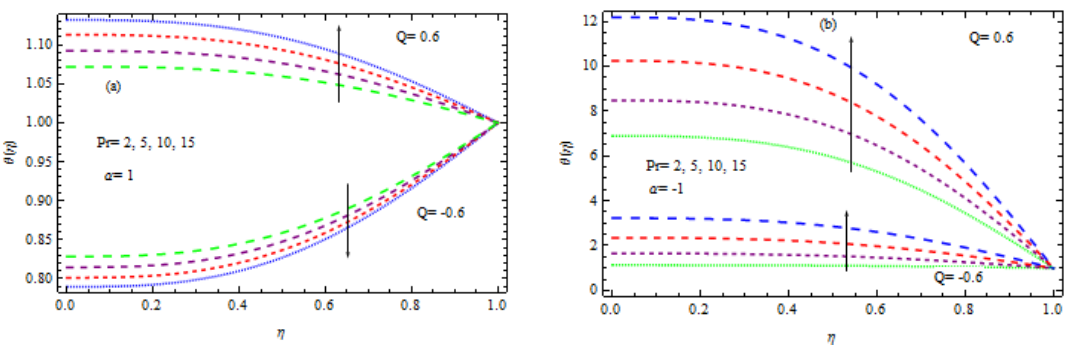
Figure 13. ( a , b ) Influence of Pr on temperature.